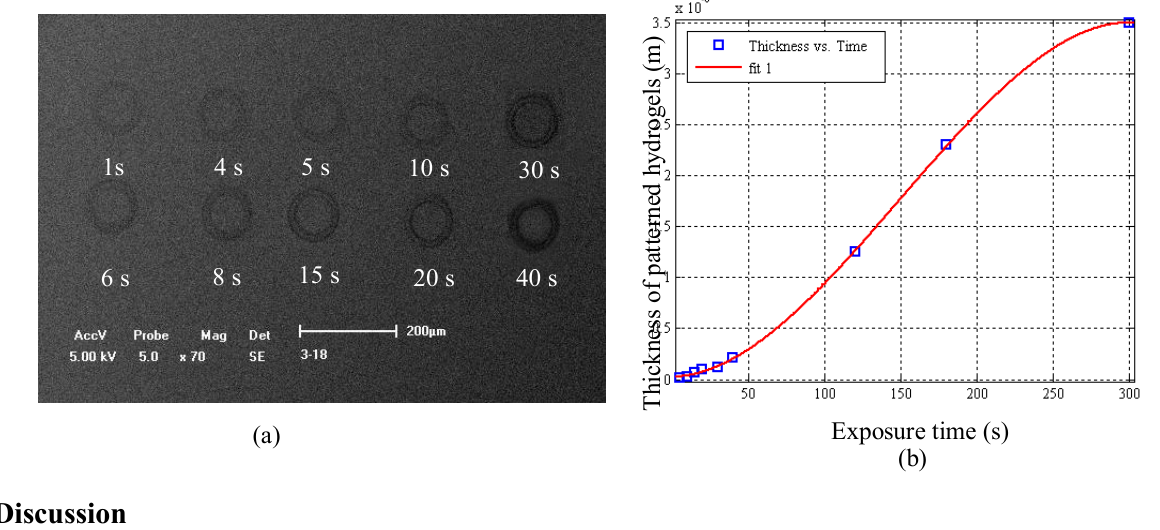
Figure 7. The thickness of patterned hydrogels as a function of the exposure time to an optical image: (a) shows circular patterns with different exposure time, and (b) shows dependence of hydrogel thickness on the exposure time. The sigmoidal fit curve shown in Figure 7(b) indicates that the thickness of the hydrogel structures increases with increasing image exposure time. Initially, the hydrogel structure’s thickness “grows” rapidly, but experiences a considerable reduction of “growth rate” away from the substrate surface as time progresses. This is due to the magnitude of induced ODEP force, which will decrease away from the chip surface, i.e. , according to our prior research results [16], the maximum induced ODEP force occurs at the edge of the optical electrodes, and decrease with increased vertical distances from the substrate. Hence, the magnitude of induced DEP force for forming hydrogel structures decreases with the increasing thickness of the structures. This phenomenon, therefore, becomes a limitation for fabricating high-aspect-ratio structures using